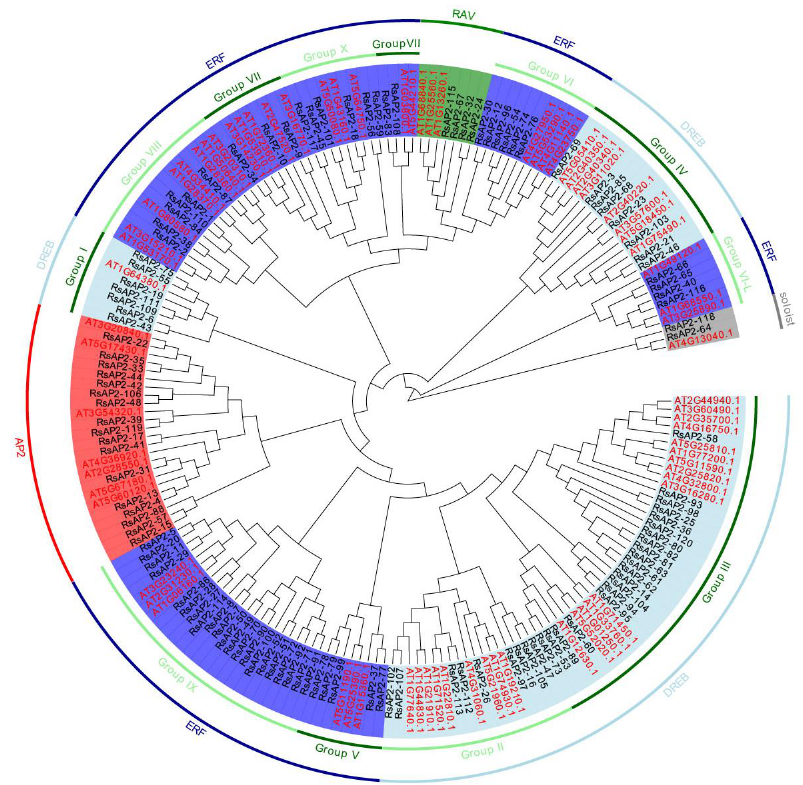
Figure 1. Phylogenetic tree of AP2 genes from Rhododendron and Arabidopsis . The identifiers colored in black are RsAP2 genes and the AP2 genes from Arabidopsis are colored in red. Subfamilies of AP2, DREB, ERF, RAV and soloist are distinguished by backgrounds shown in red, light blue, dark blue, green and gray, respectively.